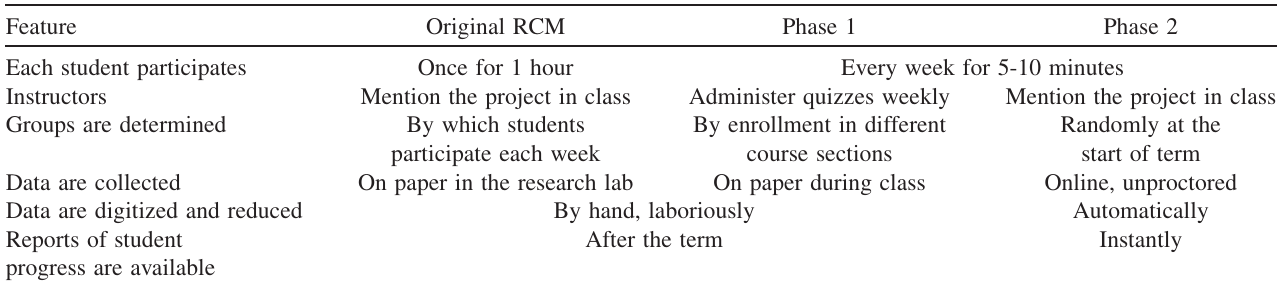
TABLE III. Methodology affordances and limitations.